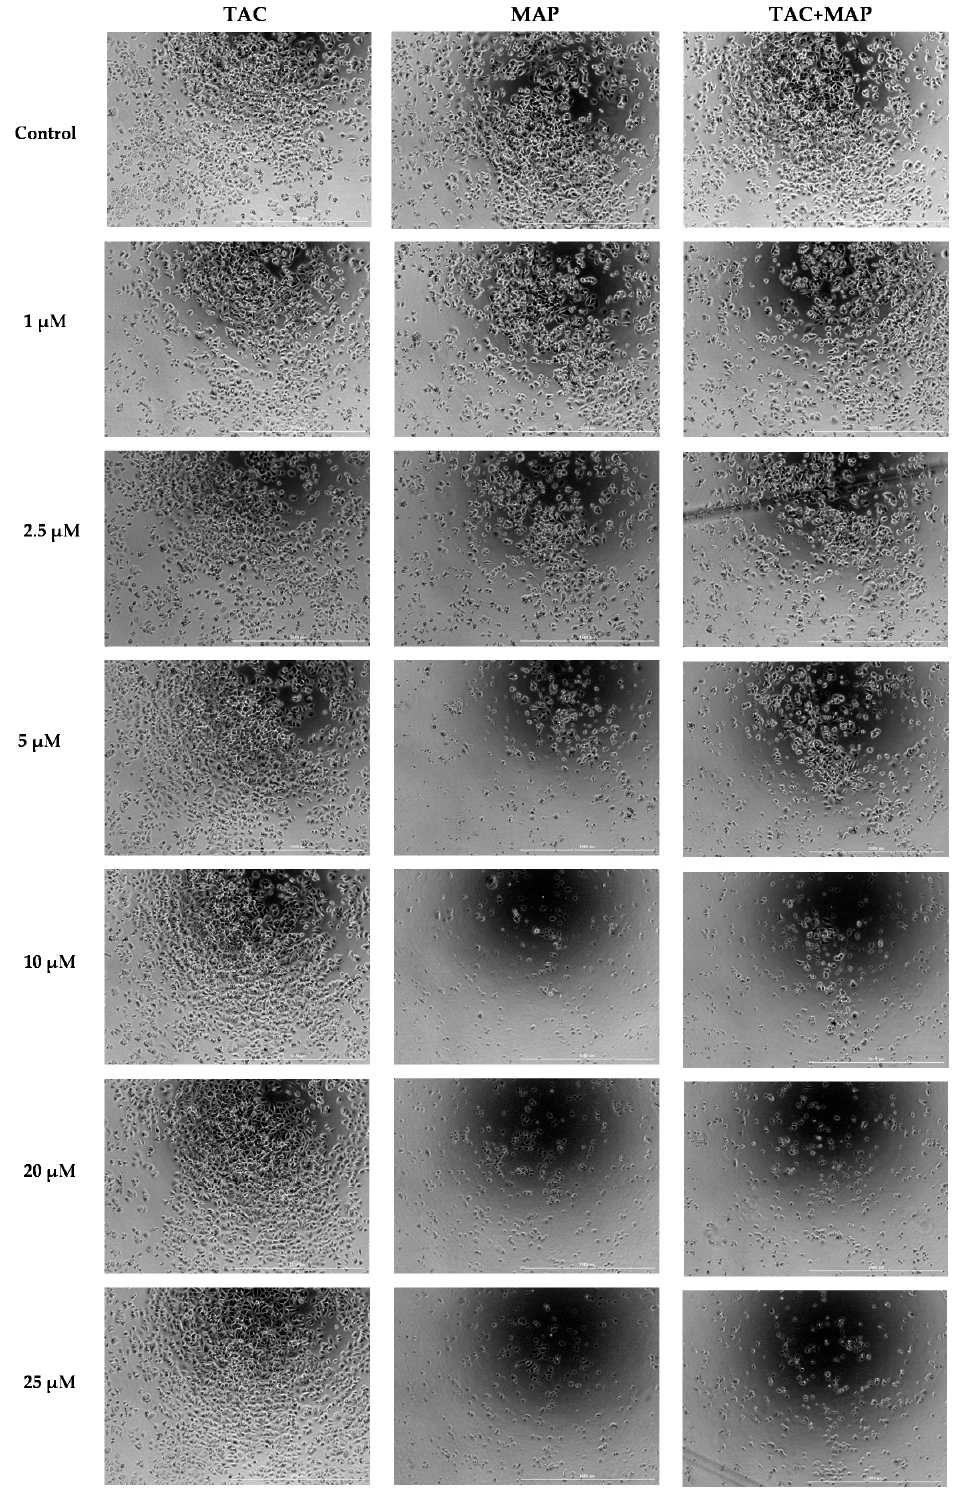
Figure 8. Micrographs (Lionheart FX of phase-contrast images) obtained for MCF-7 cells after a 24 h period of incubation with Tacrine, MAP, and MAP-Tacrine conjugate at different concentrations.